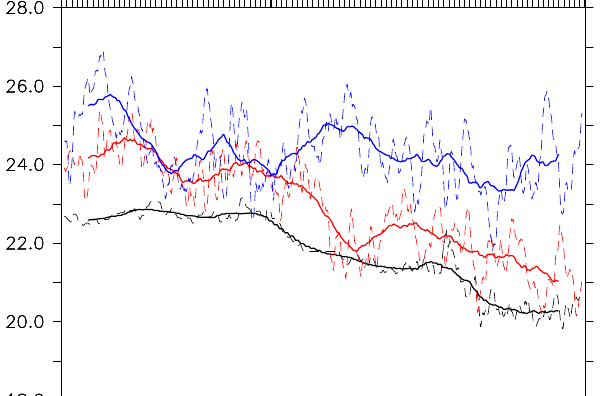
Fig. 11. Global sea ice coverage (in 10 12 m 2 ). The black line shows the HadISST (Rayner et al., 2003) data, while the blue and the red lines represent the model results from simulations PI and TRANS, respectively. Dashed and solid lines represent annual and decadal running means,